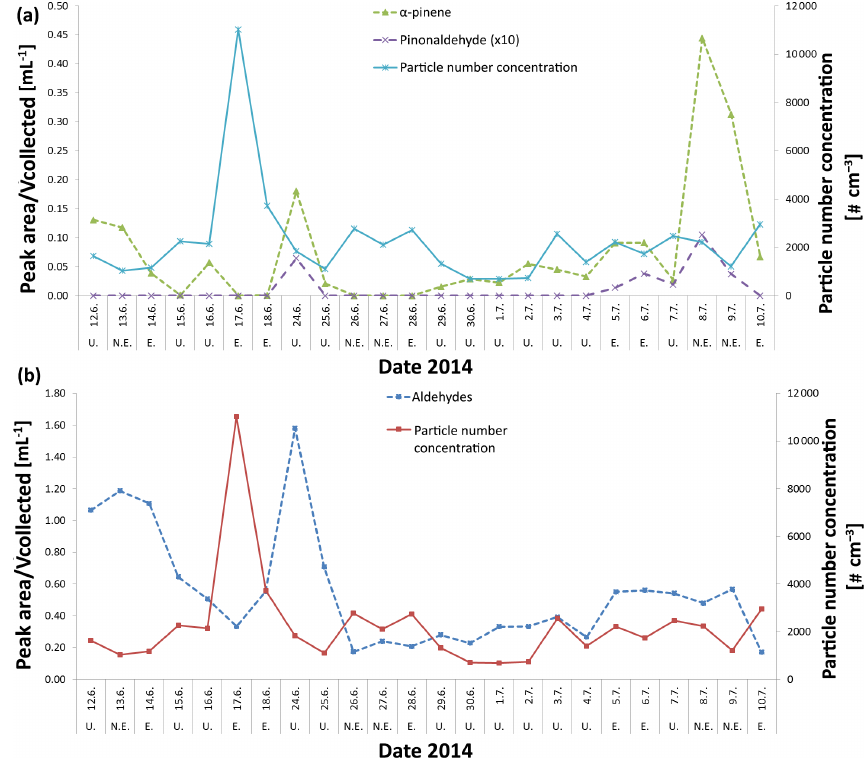
Figure 4. Comparison between the particle number concentration (#cm − 3 ) and the daily average amounts (peak areas/Vcollected) of α - pinene, pinonaldehyde (a) , and the sum of aldehydes (benzaldehyde, hexanal, heptanal, octanal, nonanal, and decanal) (b) collected by NTME and analysed by portable GC–MS in mid-summer 2014. (E. corresponds to a day when a nucleation event was observed, U. to an undefined event and N.E. to a day without nucleation